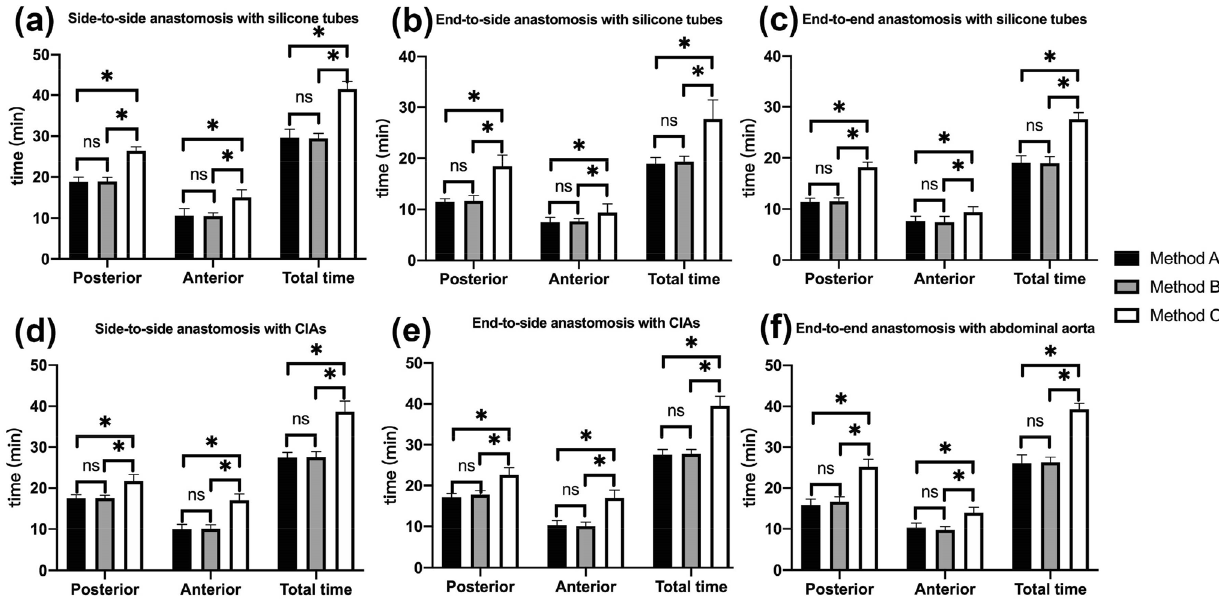
Figure 1. Comparison of the suturing time with silicone tubes ( a – c ) and rat vessels ( d – f ) with three methods in different anastomoses. The average total suturing time (Total), respective suturing time for posterior wall (Posterior) and anterior wall (Anterior) in different anastomoses with silicone tubes and rat vessels were analyzed by one-way ANOVA. In all the groups, Method A and Method B were faster than Method C in